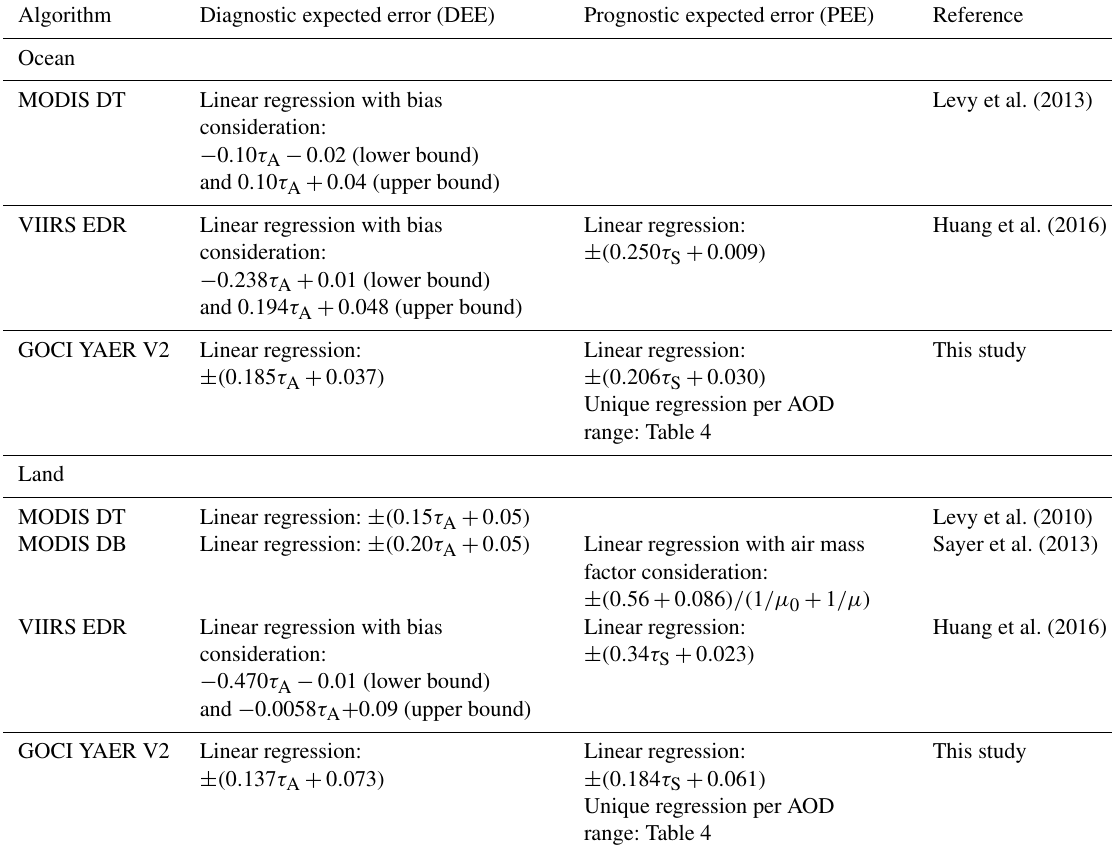
Table 3. Expected errors of MODIS C6, VIIRS EDR, and GOCI over ocean and land. µ 0 and µ are the cosine of solar zenith angle and satellite zenith angle, respectively. τ A and τ S are AERONET and satellite AOD,